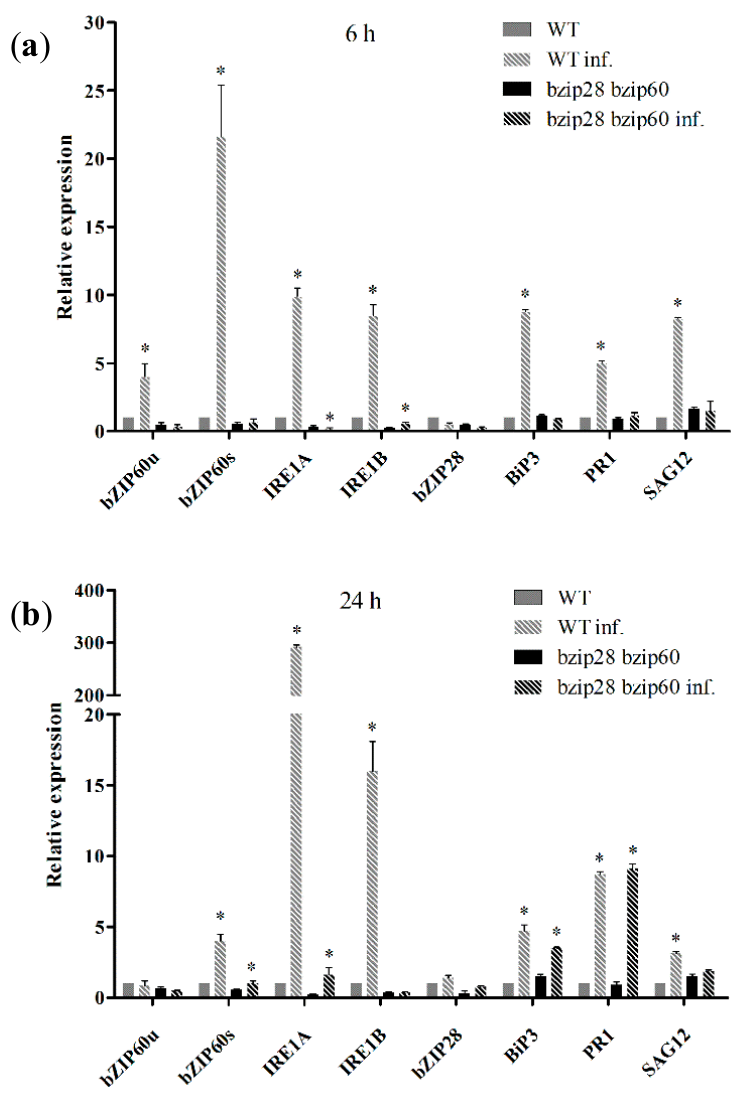
Figure 4. UPR genes transcription in leaves from WT and bzip28 bzip60 mutant Arabidopsis plants infected by D. gigantea . Analysis of relative expression of IRE1a, IRE1b, bZIP60u, bZIP60s, bZIP28, BiP3, SAG12, and PR-1 genes, following inoculation of WT and bzip28 bzip60 mutant Arabidopsis plants with a suspension of D. gigantea conidia (500,000/mL), for: 6 h ( a ), and 24 h ( b ). mRNA levels were quantified by qRT-PCR using ACT8 as housekeeping gene. The results of the infected plants are reported as fold changes with respect to non-infected WT (6 h) considered as unit. The results represent the mean values ± SD of independent experiments ( n = 3). Samples were run in technical triplicates. Statistical significance was attributed by one-way ANOVA test (* p <